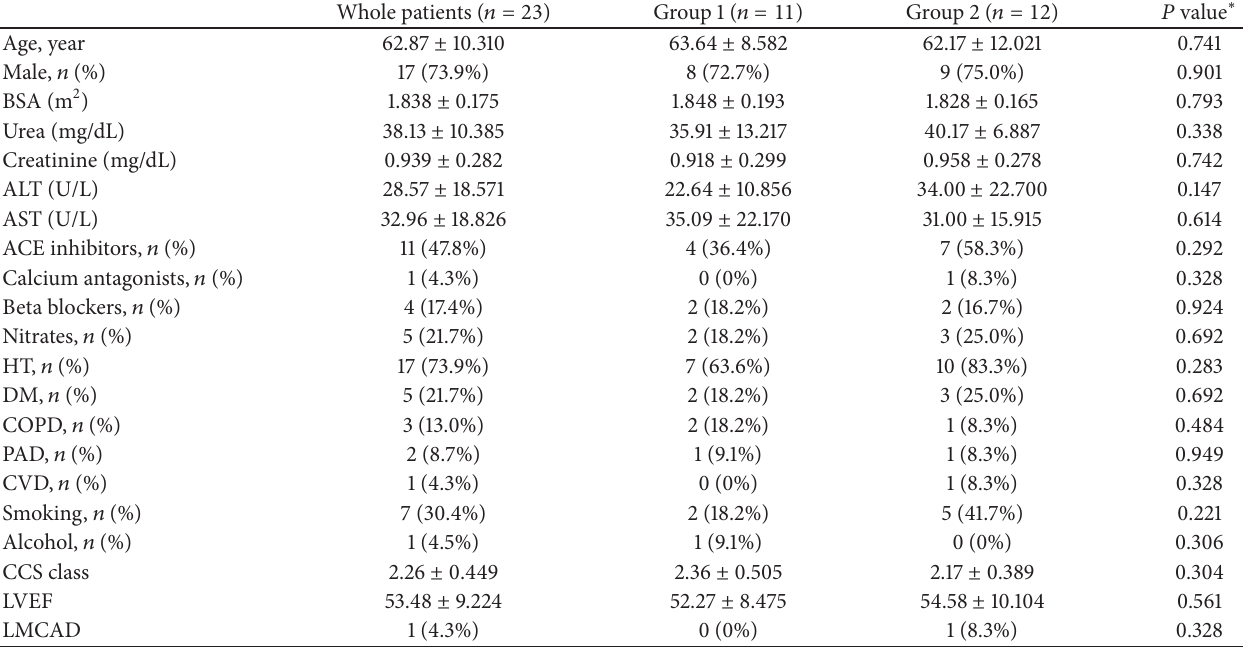
Table 1: Demographic data of groups.